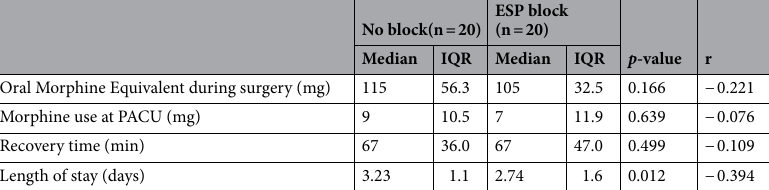
Table 2. Opioid use, recovery time and length of stay. IQR, Inter Quartile RangeA Mann–Whitney U-test was